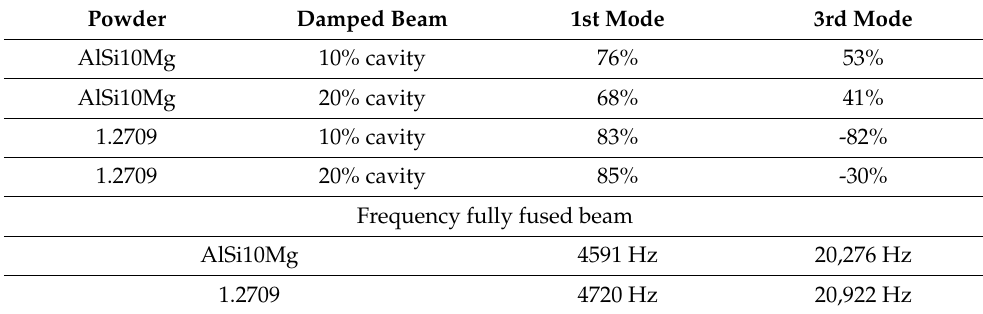
Table 6. Amplitude reduction of the FRF and natural frequencies related to Figure 13. Powder Damped